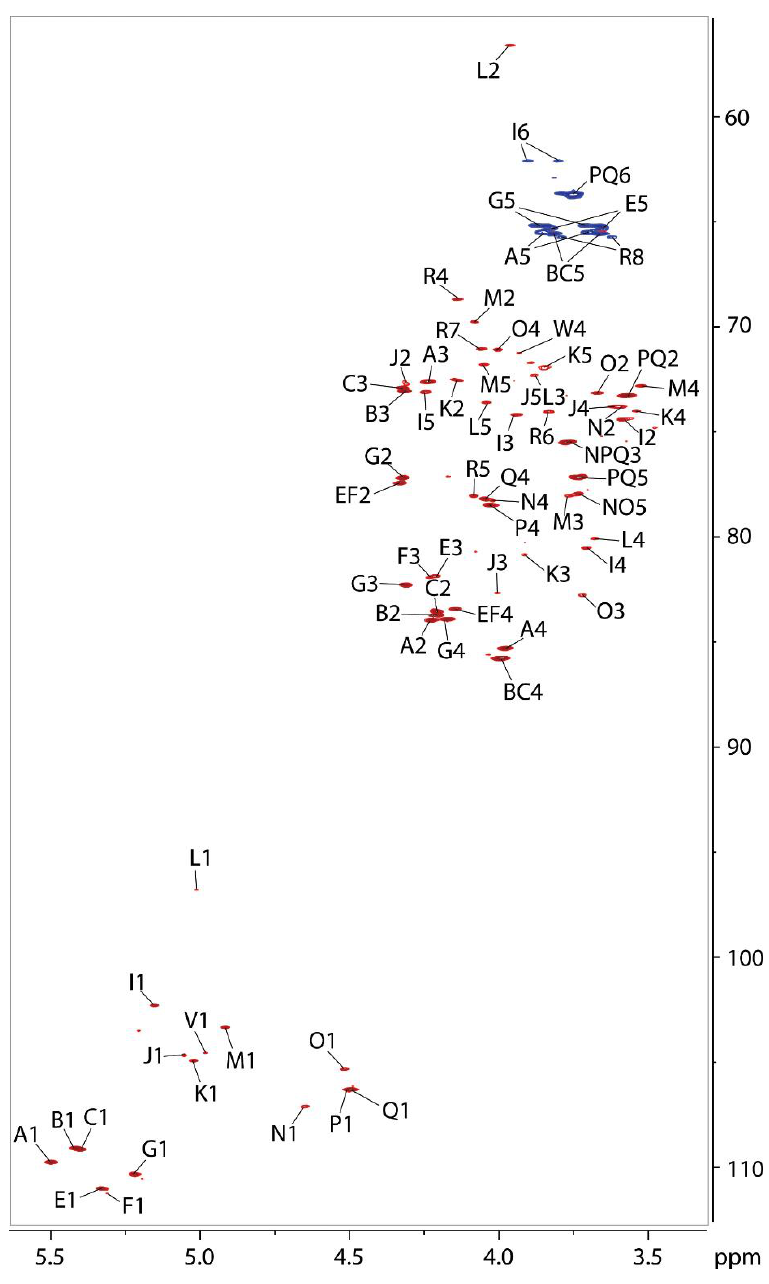
Figure 8. The partial 2-D 1 H- 13 C-HSQC NMR spectrum of the Lcr polysaccharide. The spectrum was obtained on the polysaccharide released after mild acid hydrolysis of the LPS.